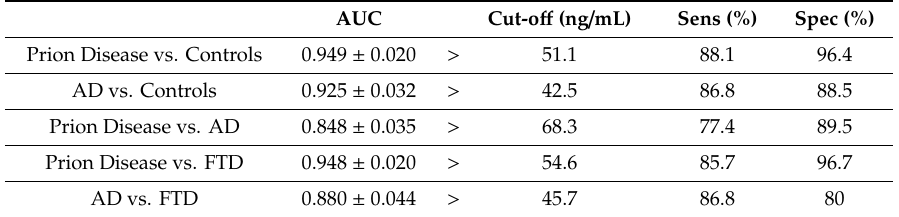
AUC Cut-o ff (ng / mL) Spec (%) Prion Disease vs.